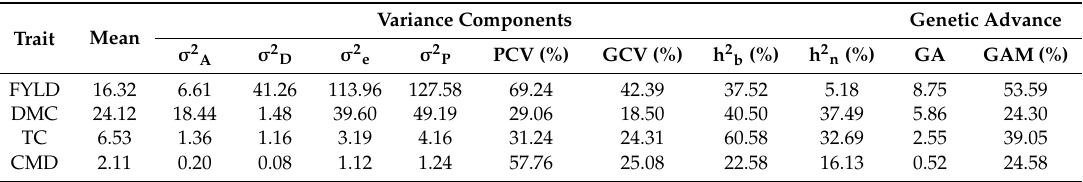
Table 9. Estimates of genetic variance components, heritability (%), and genetic advance (%) of the studied characteristics in yellow cassava